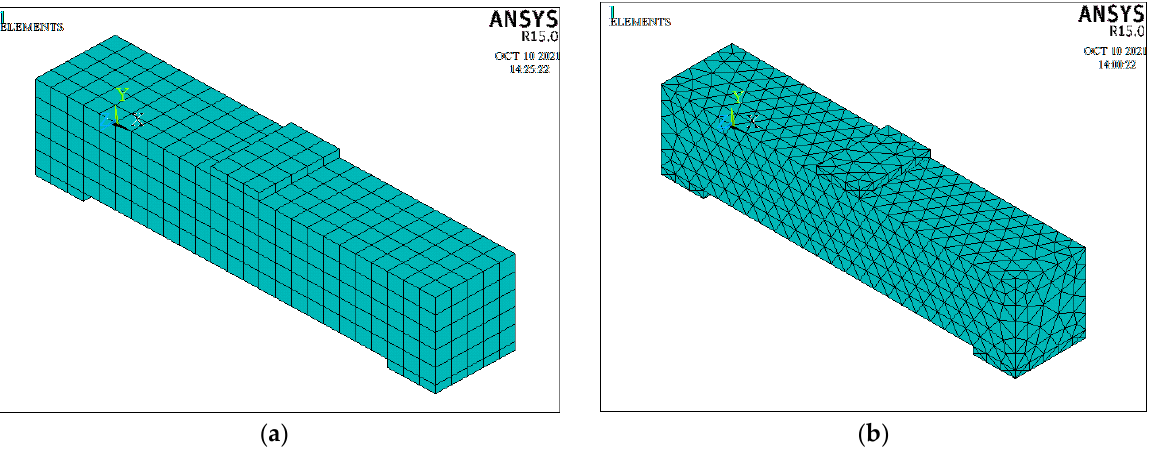
Figure 5. Different meshing patterns of a typical beam: ( a ) Homogeneous model, ( b ) heterogene- ous model.